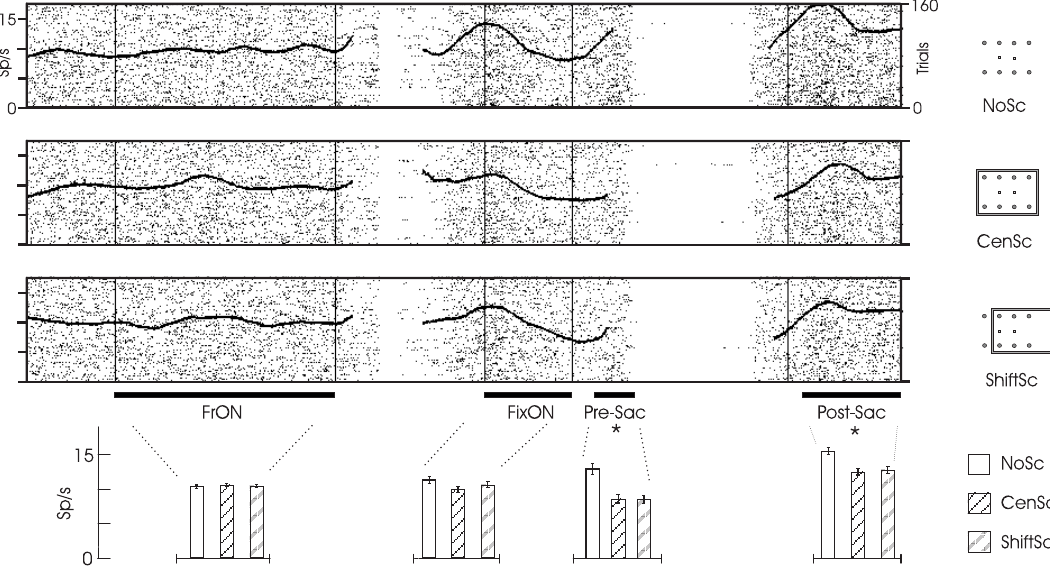
Fig. 2 – Example of a neuron with contextual scene modulation. On the raster plots in the top of the figure, the black dots and the black curve represent the cells firing and the spike density function (gaussian smoothed), respectively. The trial progresses from the left to the right. The FP and the target are turned on after the FrON or FixON periods, respectively. There is a variability in the raster length after these two periods due to the variability of the animal to acquire fixation. The average firing rate and standard error for each of the four periods in the three contexts of scene was computed and plotted in the graph below. One-way ANOVA analyzes showed a statistical significance (asterisks) between the scene contexts only after the target was turned on (P < 10 − 6 ) . The differential modulation by the scene observed just before and after the monkey begins gazing the PF is discussed in the text. See also legend for Fig.